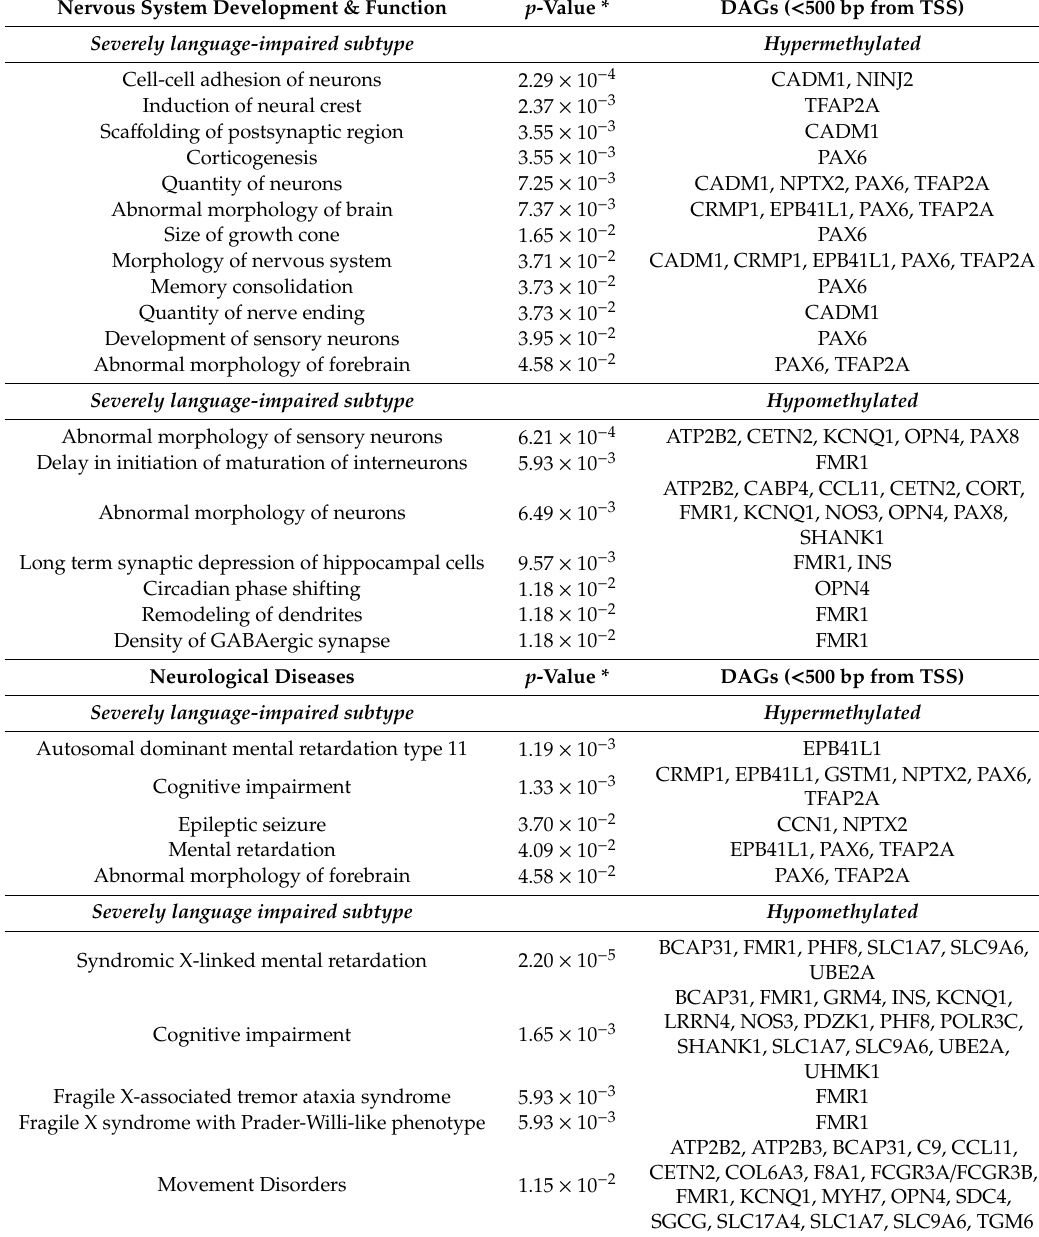
Table 3. Neurological functions and diseases enriched among DAGs implicated by CpGs within 500 bp of the TSS in the severely language-impaired